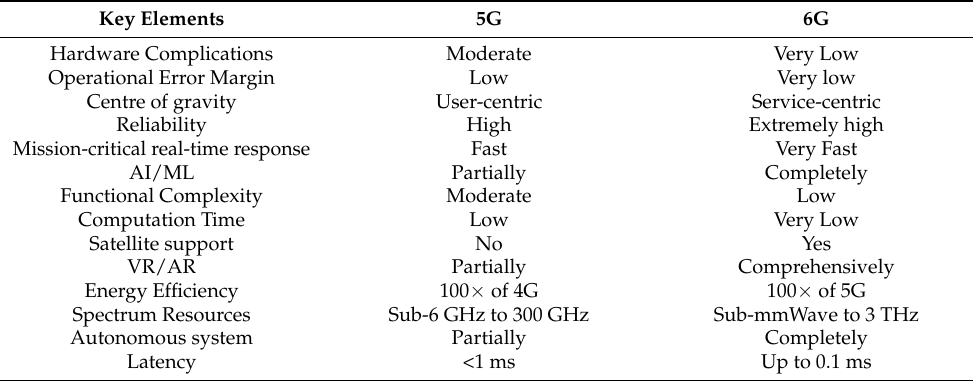
Table 1. A comparative analysis of the critical features of 5G and 6G